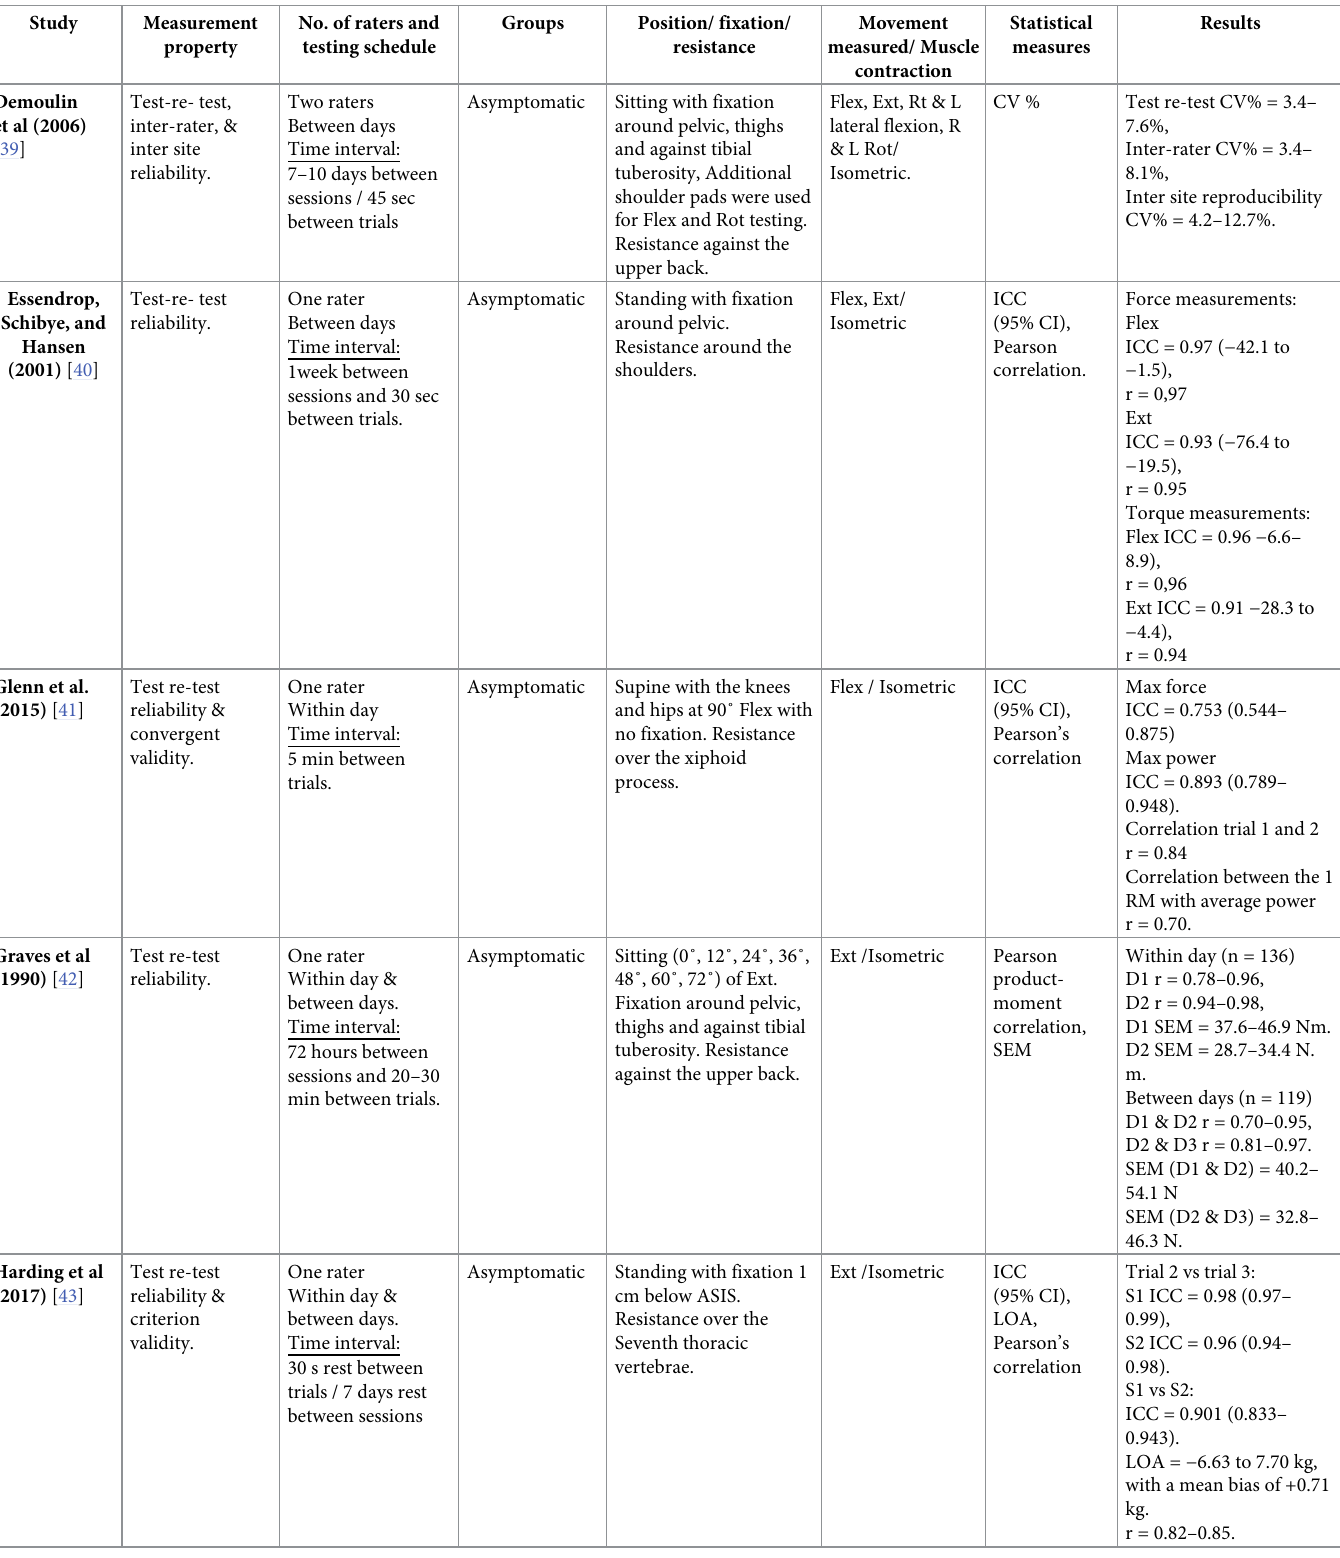
Correlation between the 1 RM with average power r =